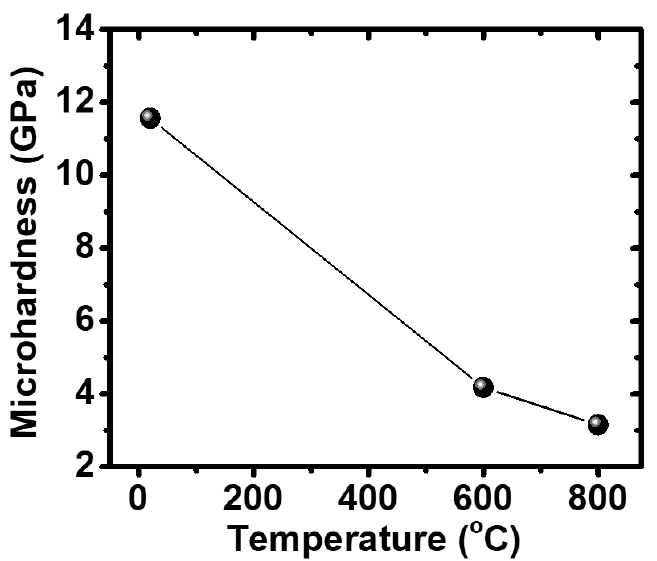
Figure 7. Vickers hardness of the sample that was ball milled for 8 h and sintered at 850 °C at different temperatures.